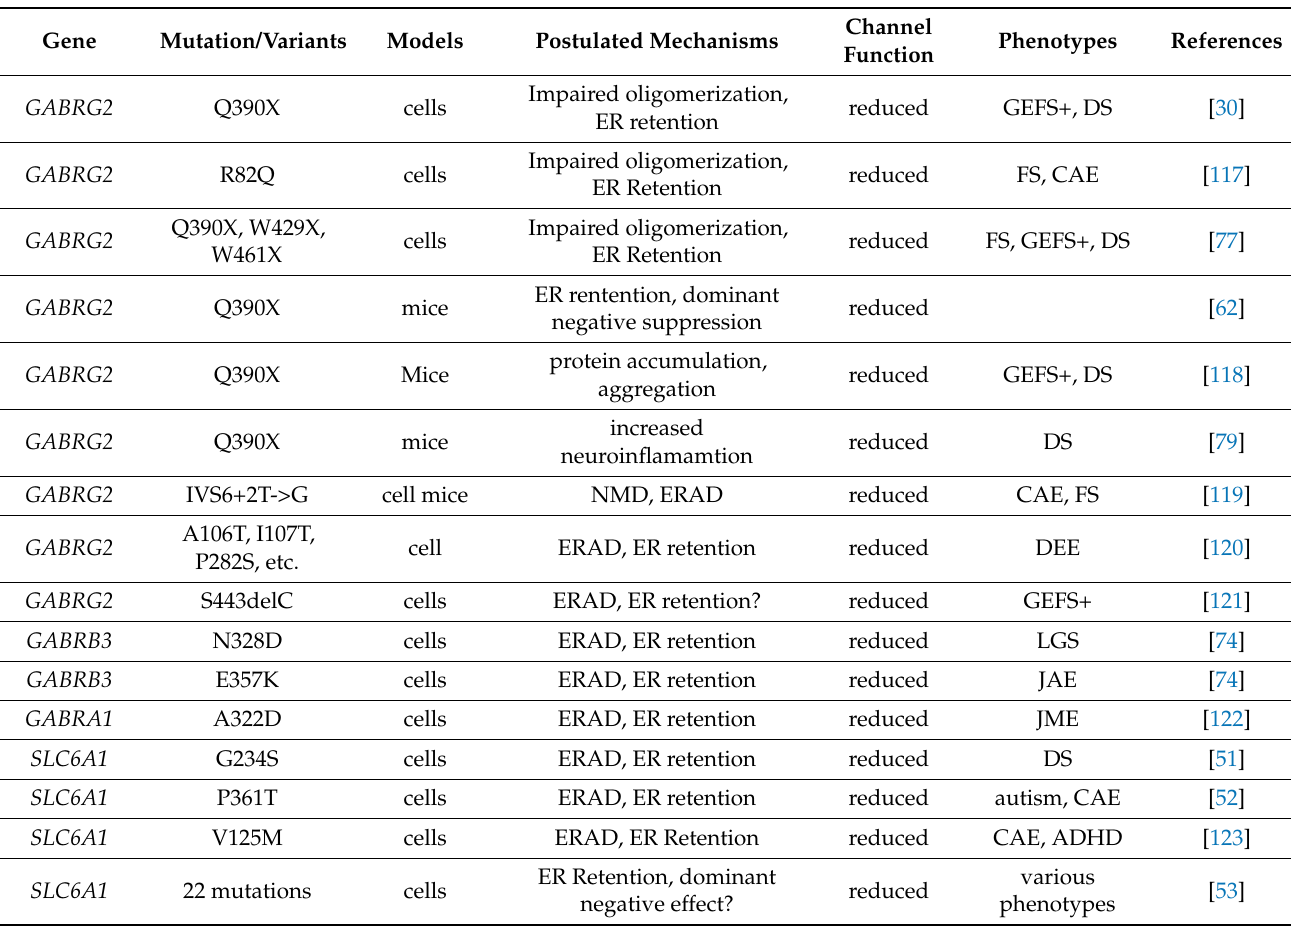
Table 1. Epileptic mechanisms in Alzheimer’s